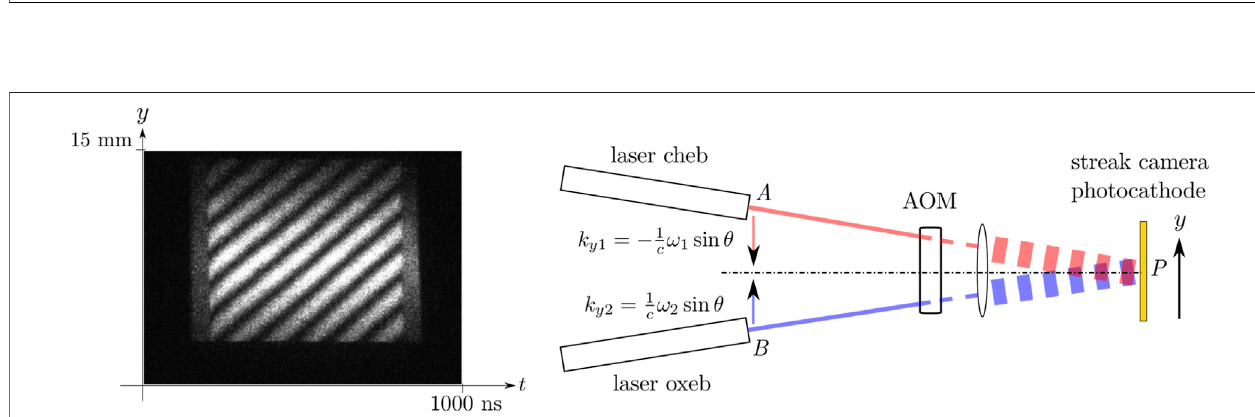
FIGURE4| Positiveslopeinterferencefringes,theoxeblaseremittedhigherfrequencyphotonsthanthecheblaser.Photonsfromtheoxeblaserfollowedthelower path BP whereas photons from the cheb laser followed the upper path AP .